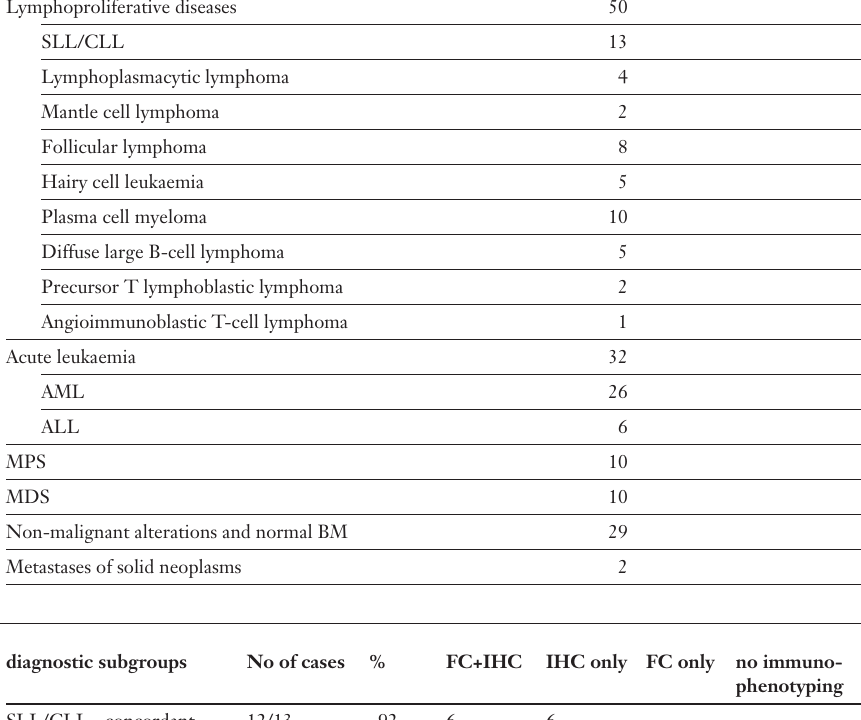
Concordance of his- tology and